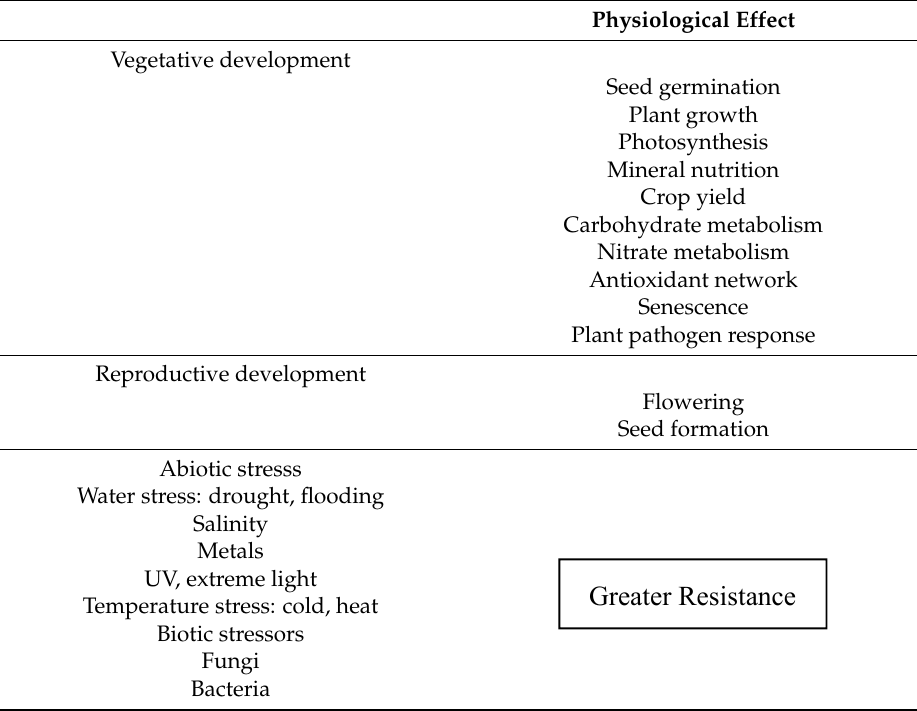
Table 1. Common physiological effects described for melatonin and SA in plants.